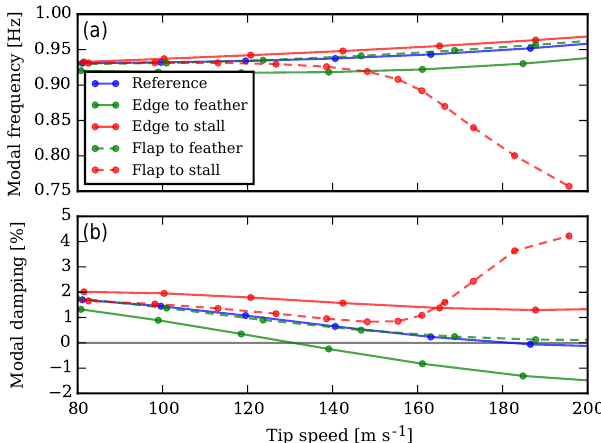
1.0 m tip deflection in the edgewise direction, and the